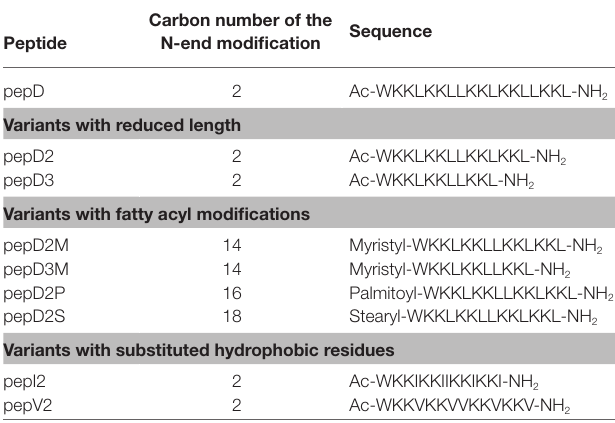
TABLE 3 | Variants of the pepD that was designed in this